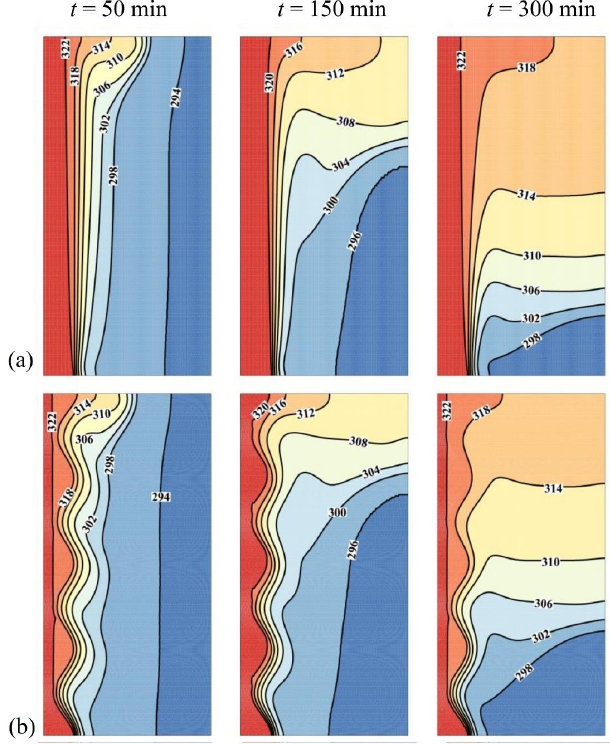
Figure 8. Comparison between contours of isotherm in different wave amplitude ( A ), ( a ): optimum case with A = 0 mm; ( b ): Case 6 with A = 3 mm, for ω na = 0.06, and N = 4.